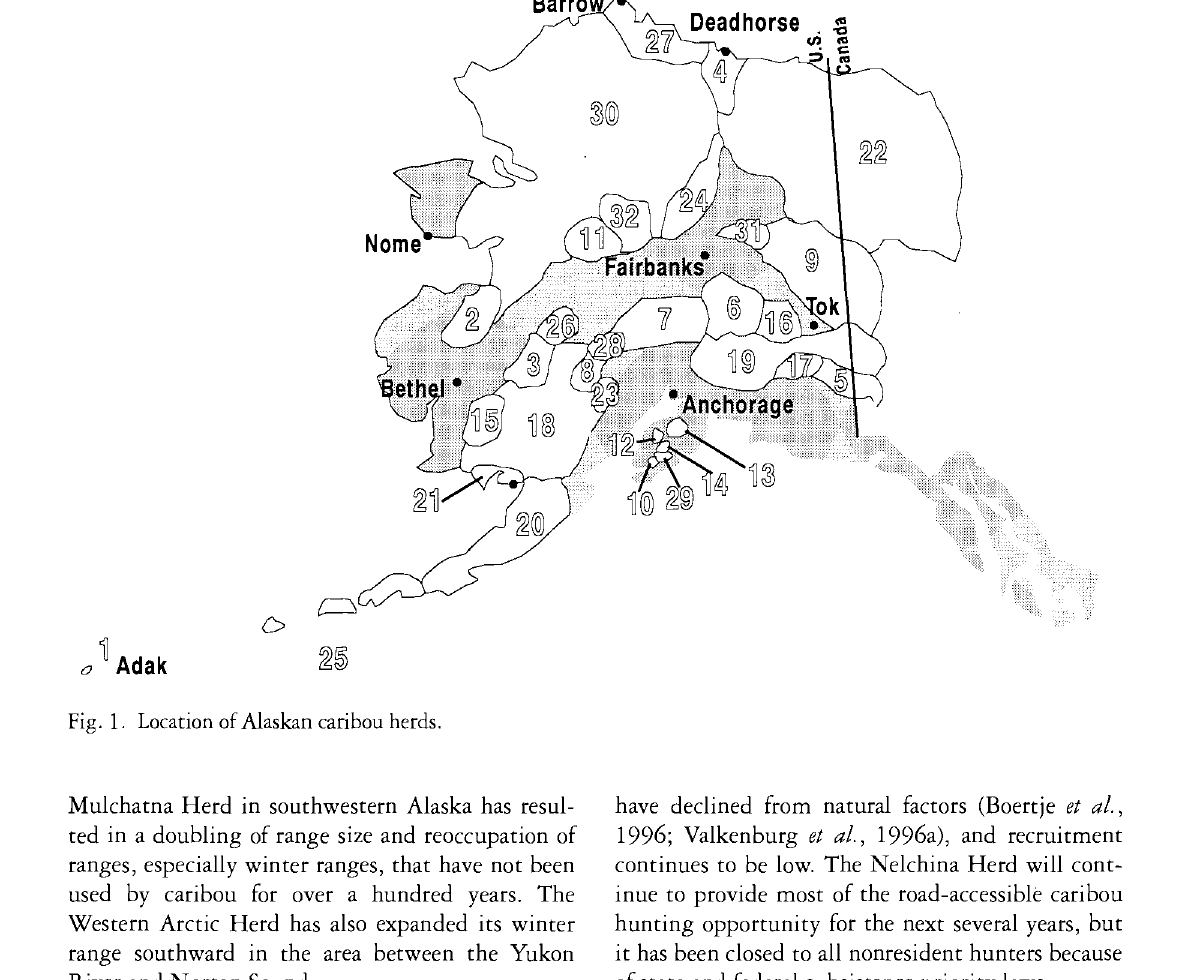
Fig. 1. Location of Alaskan caribou